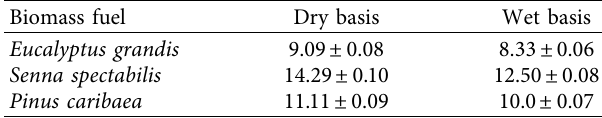
Table 3: Moisture content (%) of the biomass fuels used. Biomass fuel